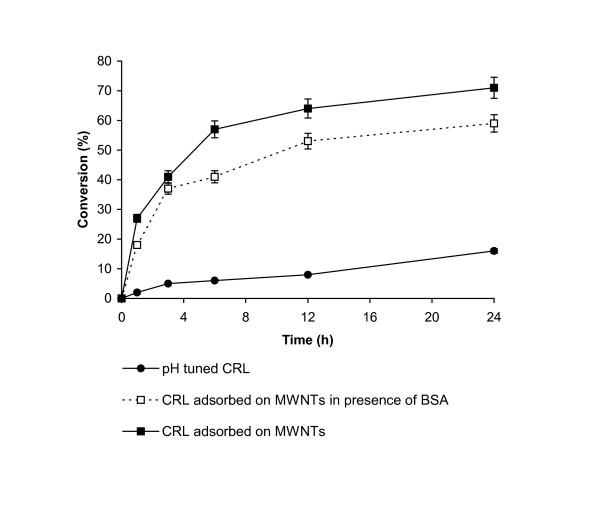
Transesterification of ethyl butyrate with butanol in [Bmim] [PF6]. Each point represents the outcome of a pair of readings.